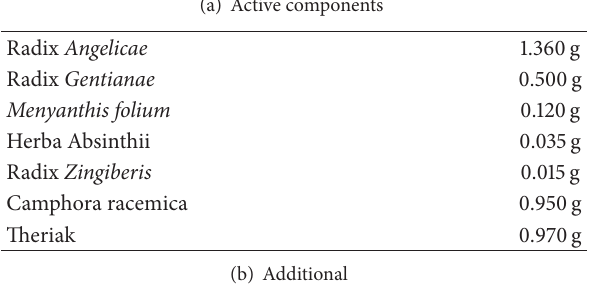
Table 1: Composition of PERVIVO